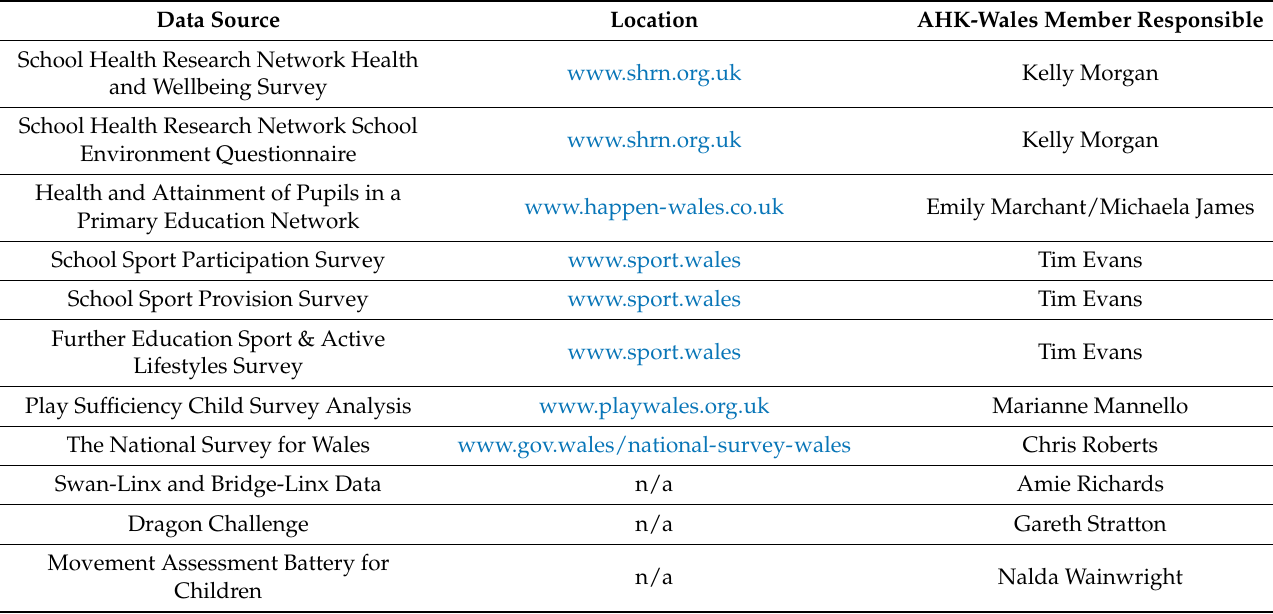
Table A1. The location of the data sources, where applicable, and the AHK-Wales member to contact if more information is required about that data